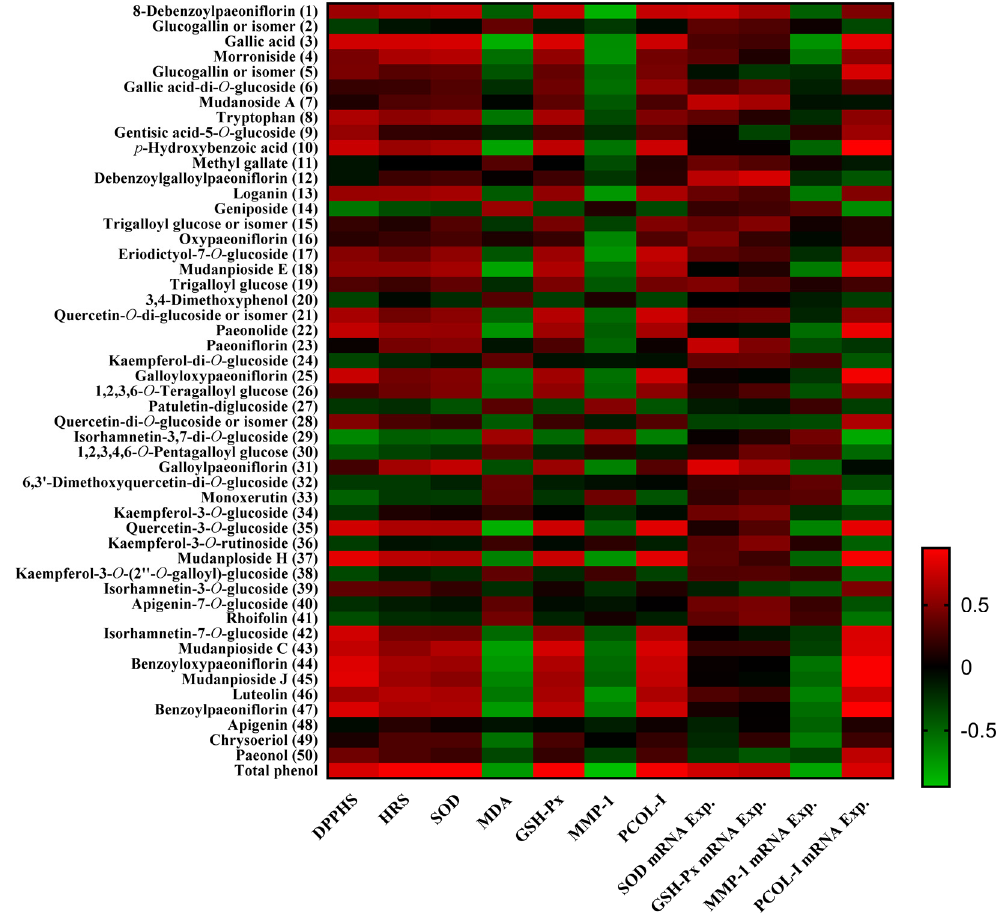
Figure 6. Correlation analysis between phytochemicals and bioactivities. The numbered compounds are consistent with that in Figure 5. DPPHS: DPPH scavenging; HRS: hydroxyl radical